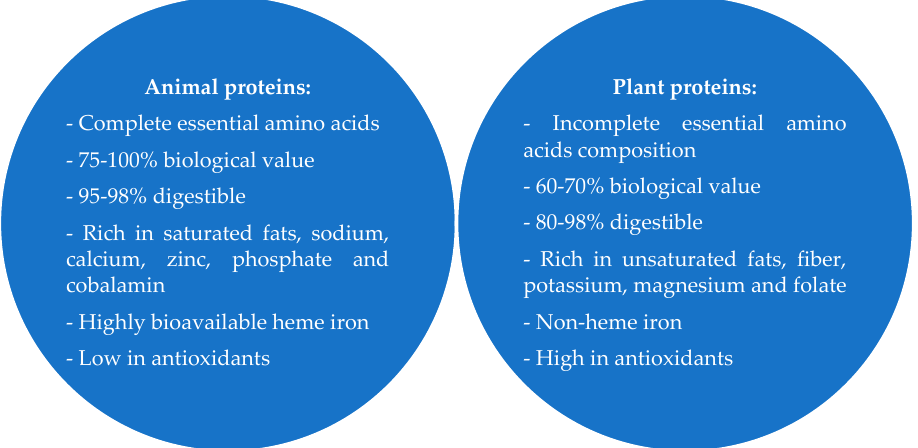
Figure 5. Animal and plant protein comparison based on Berrazaga et al., 2019 [158].